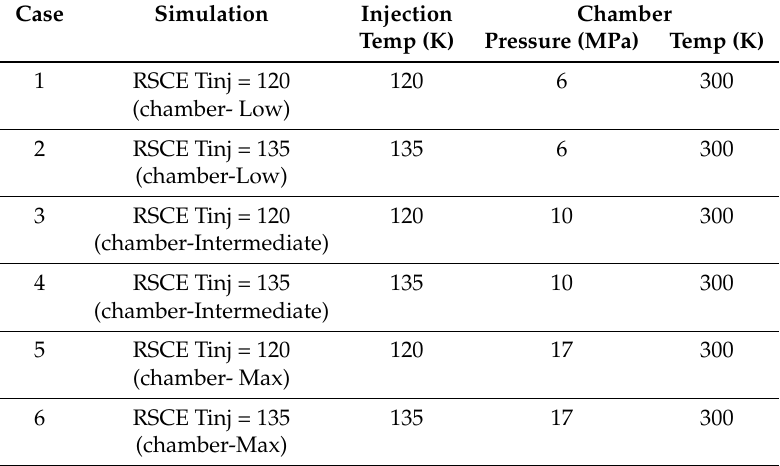
Table 2. Table of cases of LN 2 injection at 2 m/s through a 2.2 mm diameter orifice into a chamber filled with gaseous N 2 for simulating various compression chamber